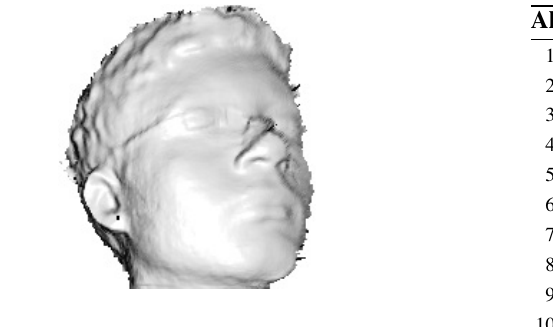
Fig. 3. An example of user’s head reconstructed with the KinectFusion and rendered with Phong shading [22].